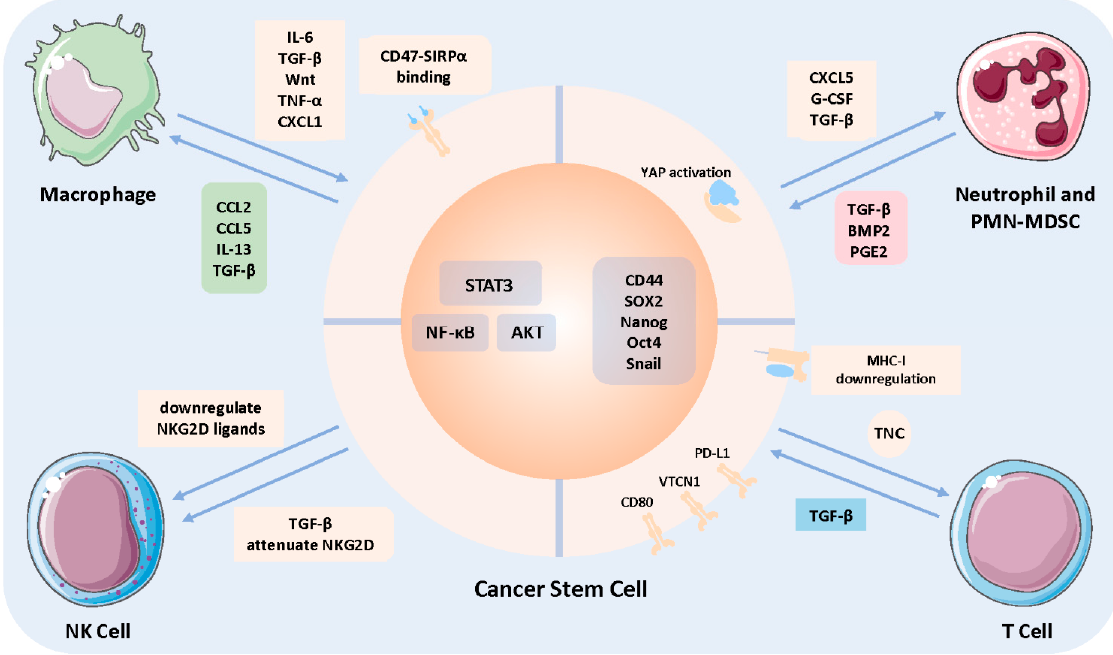
Figure 2. Interaction between cancer stem cells and immune components. Interaction between CSCs and immune cells are mutual and complex, and their interaction are accomplished mainly through intercellular cytokines communication. (1) Interaction with macrophage: CSC-secreted CCL2, CCL5, and TGF- β lead to immune incompetency of macrophage, thus preventing eradication; macrophage-secreted IL-6, Wnt, and TGF- β could enhance CSC stemness; moreover, the CD47 “do not eat me” signal presented by CSC avoids phagocytosis. (2) Interaction with TAN and PMN-MDSC: TAN-secreted TGF- β and BMP2 lead to dedifferentiation of cancer cells into CSC, and PMN-MDSC could upregulate stemness regulatory transcription factors; CSC-secreted chemokines recruit more TAN and PMN-MDSC to form the suitable immune microenvironment. (3) Interaction with NK cell: Owing to the prominent cytotoxic function of NK cells, CSCs mainly downregulate NKG2D ligands level to avoid killing. (4) Interaction with T cell: CSCs attenuate MHC-I expression and upregulate immune checkpoints to prevent immune recognition and attack, conversely, CSC-secreted tenascin C retards T cells proliferation to thrive. Overall, CSC-secreted cytokines are responsible for inducing incompetency of immune cells; and immune-cell-released ones are crucial for maintenance and strengthening of stemness to enhance the refractoriness of cancer. Abbreviations: BMP2, bone morphogenetic protein 2; G-CSF, granulocyte colony stimulating factor 6; PGE2, prostaglandin E2; SIRP α , signal regulatory protein alpha; TNC, Tenascin C; VTCN1, V-set domain-containing T-cell activation inhibitor 1; YAP, Yes1-associated transcriptional regulator.